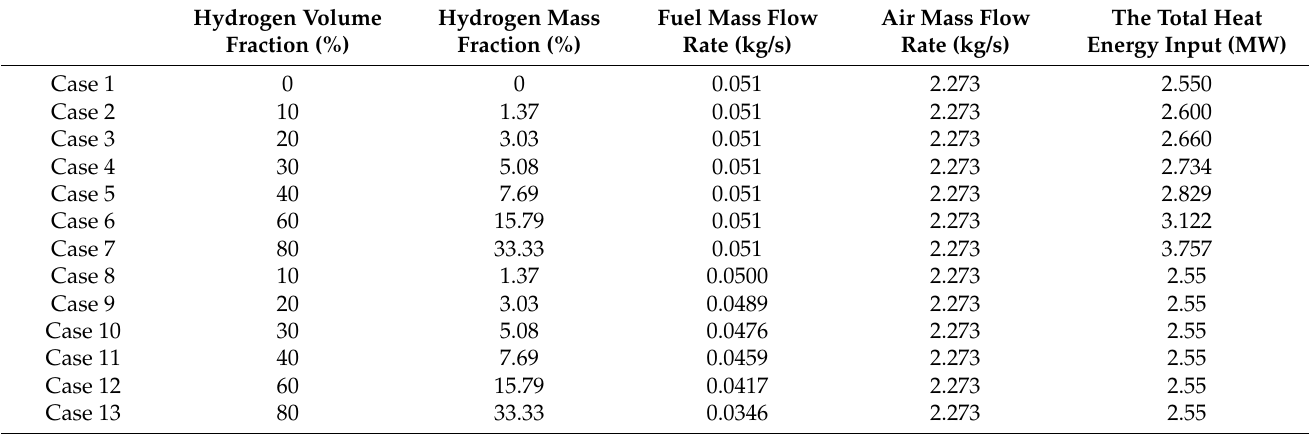
Table 1. The parameters under the conditions of constant energy input and fuel mass flow rate.